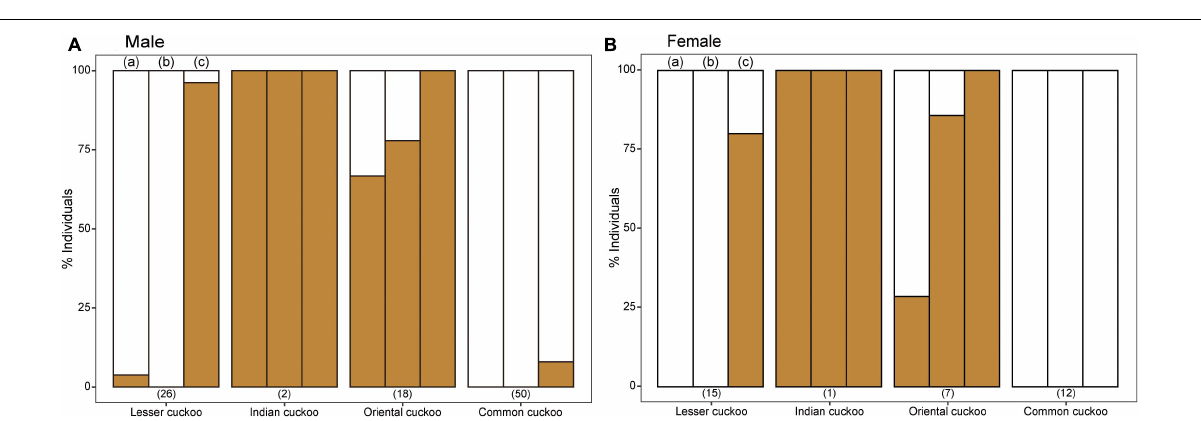
FIGURE 4 | The relative proportion of the four Cuculus cuckoos according to their underpart background colors: either pure white or yellowish-brown tinge. The colors of different areas of underpart [i.e., (a) belly, (b) underwing covert, and (c) undertail covert] were accessed separately. The numbers in the parentheses represent the sample size. (A) Male Cuculus cuckoos, (B) Female Cuculus